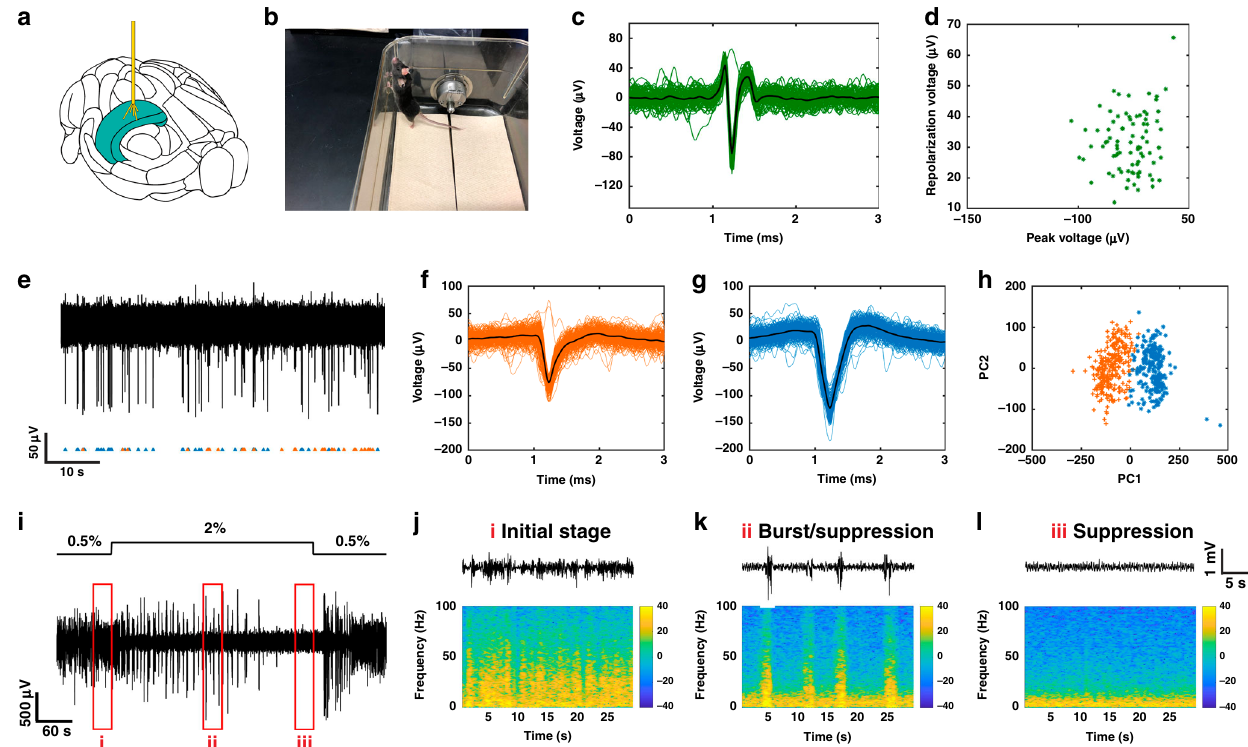
Fig. 3 Spontaneous activity investigation by spatially expanded functional fi ber probes (F1, n = 5). a An illustration of the spatially expanded fi ber probe targeting the hippocampus region in a mouse brain. b A photograph of a wild-type mouse with small electrodes implanted for 5 weeks. c A single cluster segregated 5 weeks after implantation from electrode one and d it ’ s peak voltage and repolarization voltage. e – h Filtered endogenous activity 5 weeks after implantation from electrode two containing two separable units. f – g Action-potential shapes of the two units. h Principal-component analysis (PCA) of the two units. i Local fi led potentials recordings 8 weeks after implantation from electrode one with the alternating anesthesia level (0.5 – 2% v/v iso fl urane). j – l Different levels of LFP activity recorded under the varying concentration of iso fl urane, where j shows the initial stage (before the increase of iso fl urane level), k shows burst/suppression stage (transition period) and l shows suppression stage (deep anesthesia period). Representative images are shown taken from fi ve